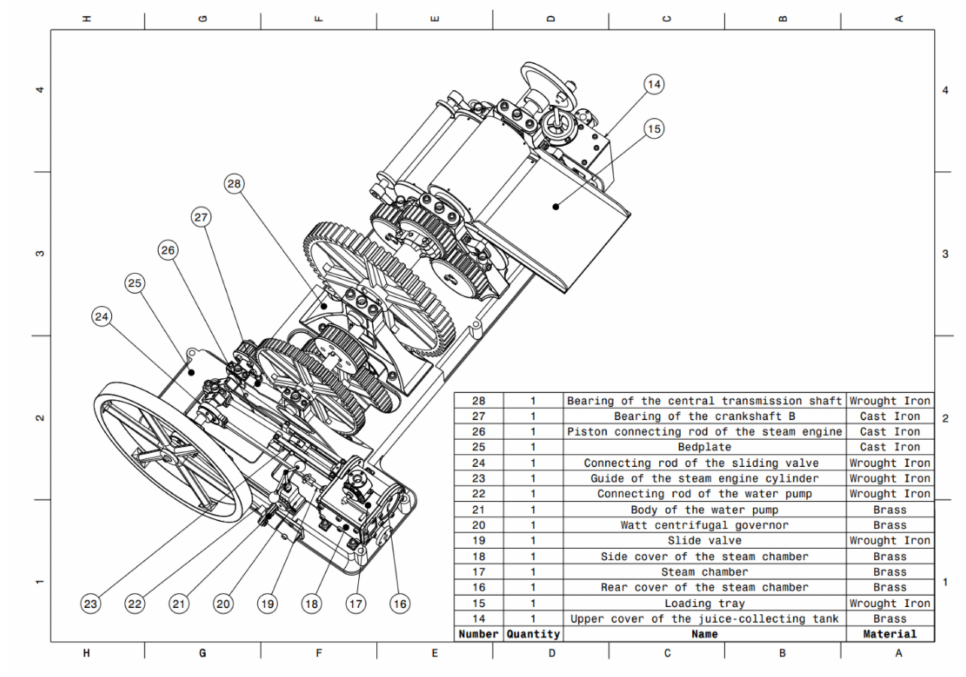
Figure 3. Assembly plan from rear view (Elements